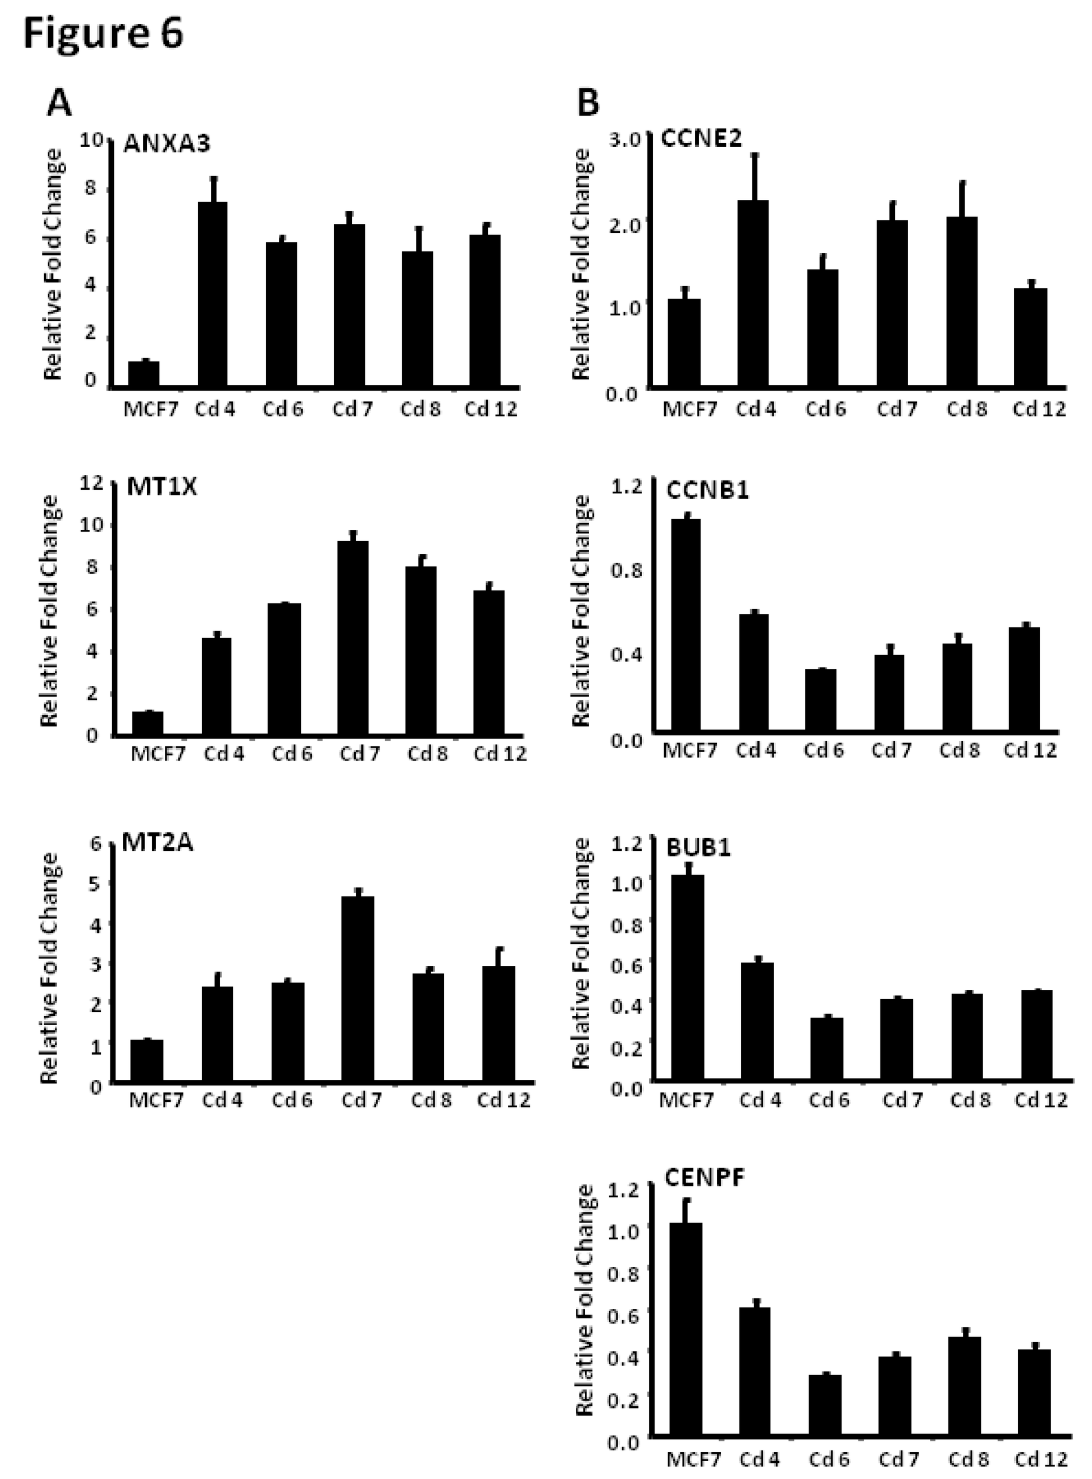
Figure 6. Confirmation of DE genes using quantitative RT-PCR. MCF-7 and MCF-7-Cd clonal cell lines (Cd-4, -6, -7, -8, and -12) were plated in 10 cm plates and total RNA was isolated for gene expression analysis using quantitative RT-PCR. Data are presented as relative fold changes with MCF-7 as the control and all fold changes are normalized to GAPDH (relative fold=2 ∆∆Ct gene/ ∆∆CtGAPDH ) with p<0.001. doi: 10.1371/journal.pone.0084646.g006 PLOS ONE |